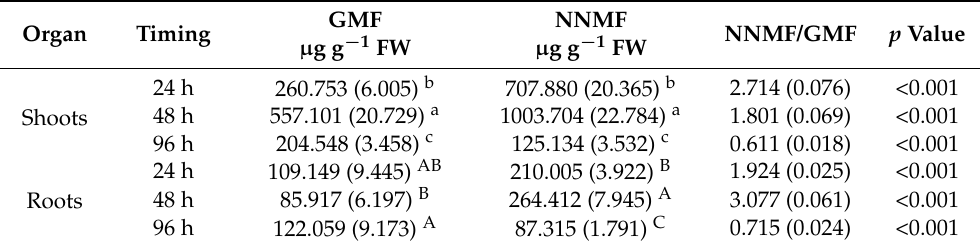
Table 8. Time-course analysis of total polyphenol contents in Arabidopsis thaliana under GMF and NNMF. Values are expressed as µ g g − 1 FW or fold change (NNMF/GMF). Within the same column,